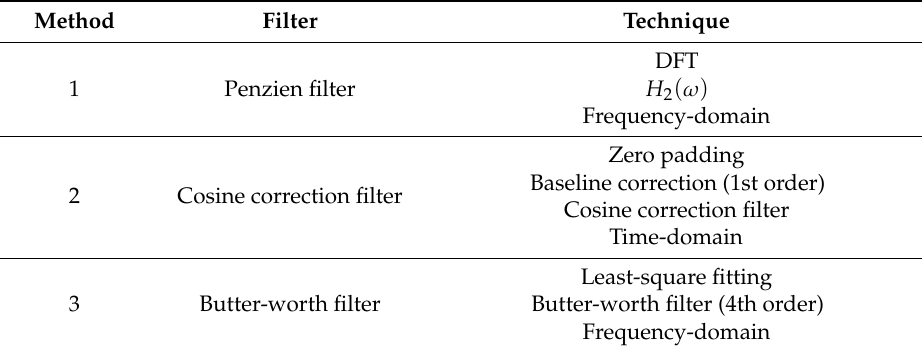
Table 3. Techniques for AVD conversion methods.